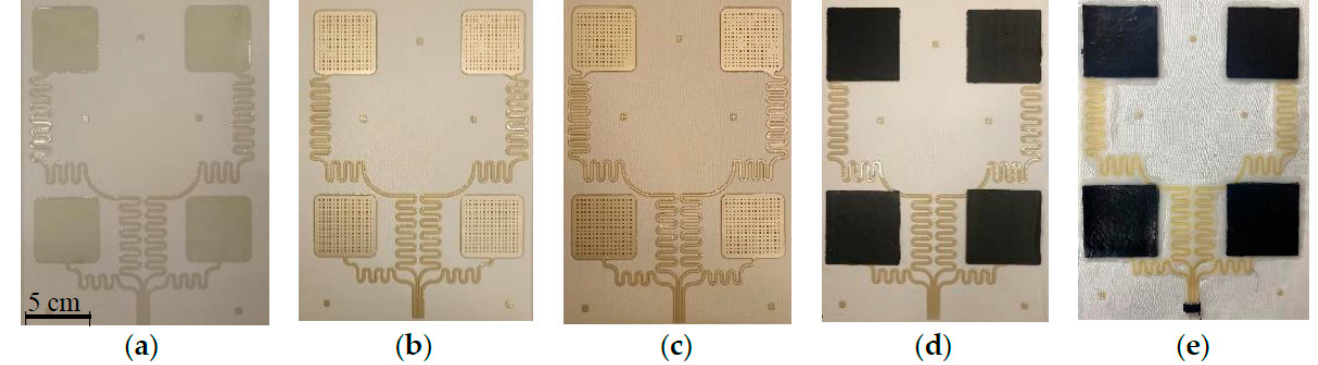
Figure 4. Electrode textile printing process: ( a ) interface layer; ( b ) conductive silver layer; ( c ) encapsulation layer; ( d ) car- bon rubber layer; ( e ) rubber layer.